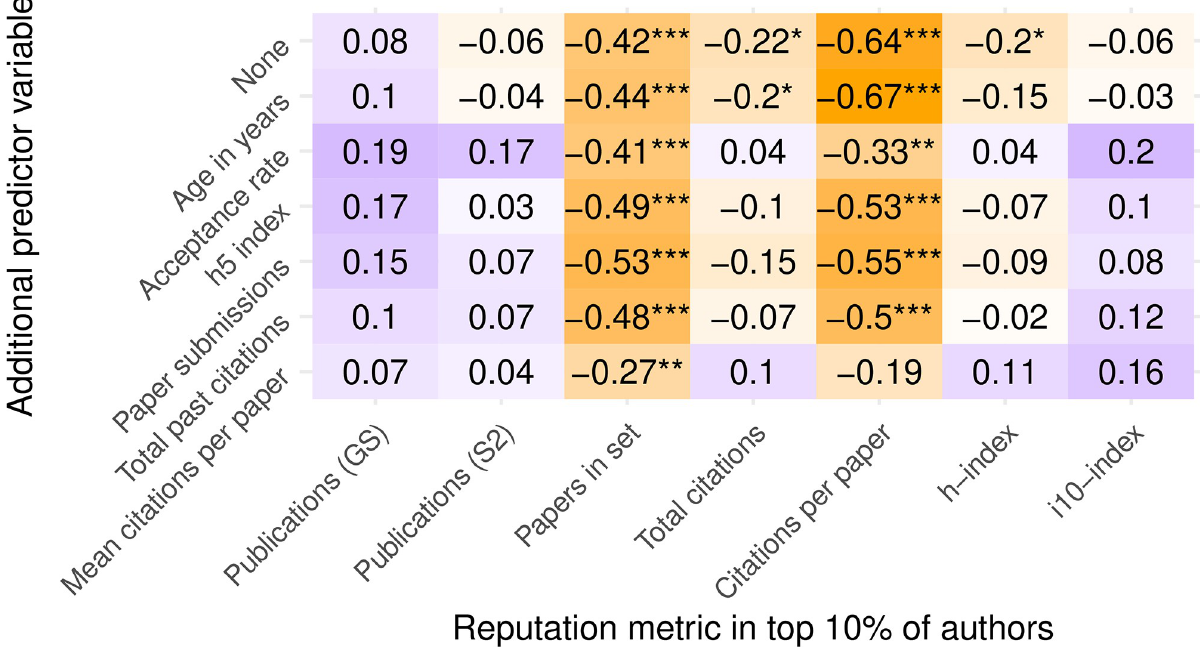
Fig 10. Logistic regression of the top decile of various author prestige metrics as predicted by review policy and other conference variables. Values shown are the coefficient of DB reviewing in the logistic model and their associated p-values. Positive coefficients (purple) indicate higher reputation in SB conferences. Negative coefficients (orange) indicate higher reputation in DB conferences. Darker colors reflect larger-magnitude values. Stars indicate p values below 0.05, 0.01, and 0.001, respectively.